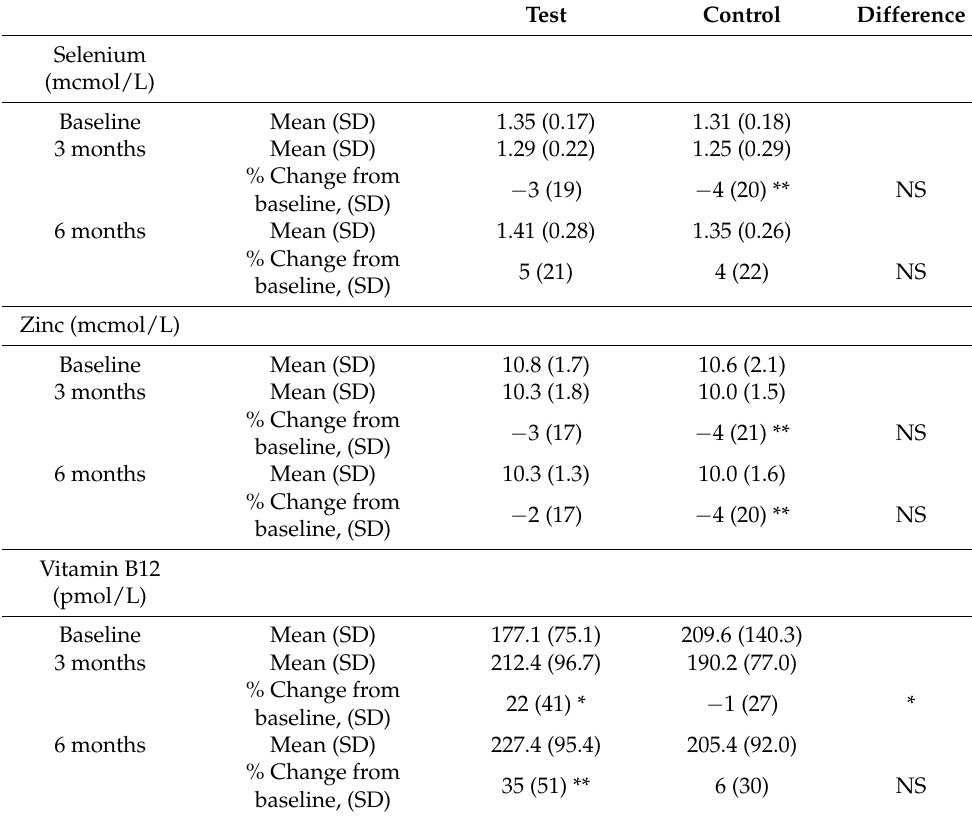
Table 6. Changes in micronutrients (secondary endpoints) in response to test and control products over six